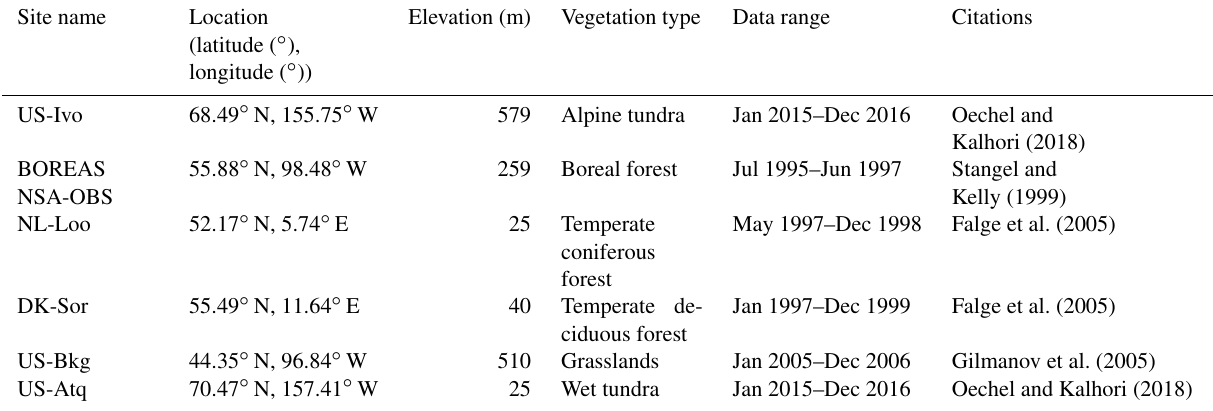
Table 4. Site description and measured volumetric soil moisture data used to validate